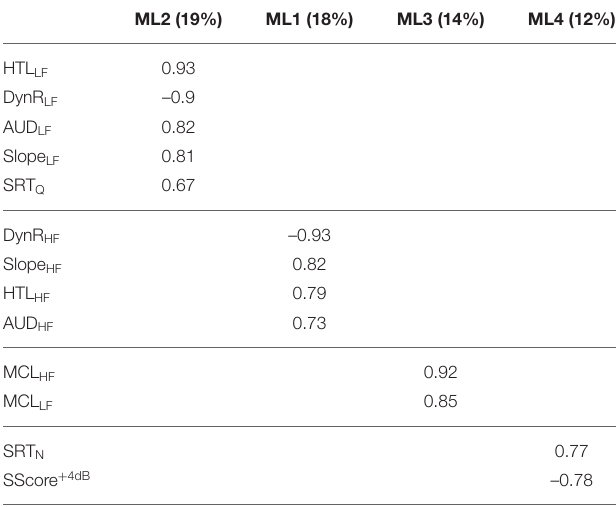
TABLE 11 | Variables correlated to the four latent orthogonal factors resulting from the factor analysis with the method of maximum likelihood